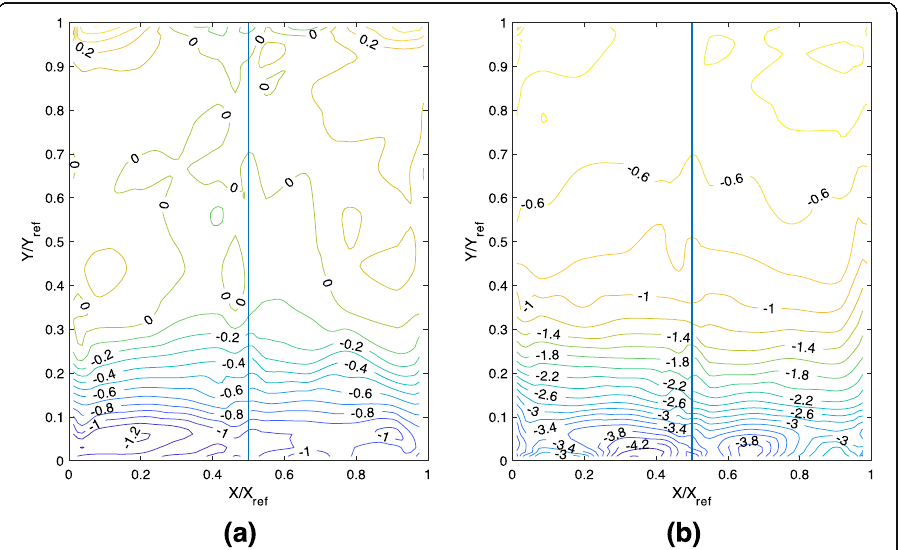
Fig. 9 Contours of roof pressure coefficients ( θ = 0 deg.), for the 3 ft. parapet case: ( a ) mean Cps, and ( b